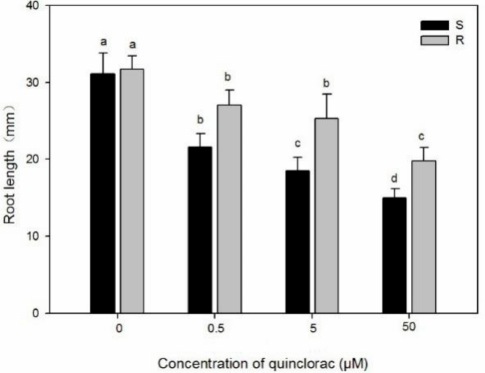
Figure 1. Root length of two biotypes at 7 days after treatment with 0 µ M, 0.5 µ M, 5 µ M and 50 µ M quinclorac. S represents the susceptible biotypes (JNNX-S), and R represents the resistant biotypes (SSXB-R). Data are the mean values of at least 10 biological replicates. The standard errors of the means are described by vertical bars. ANOVA significance groupings are shown as a, b and c.